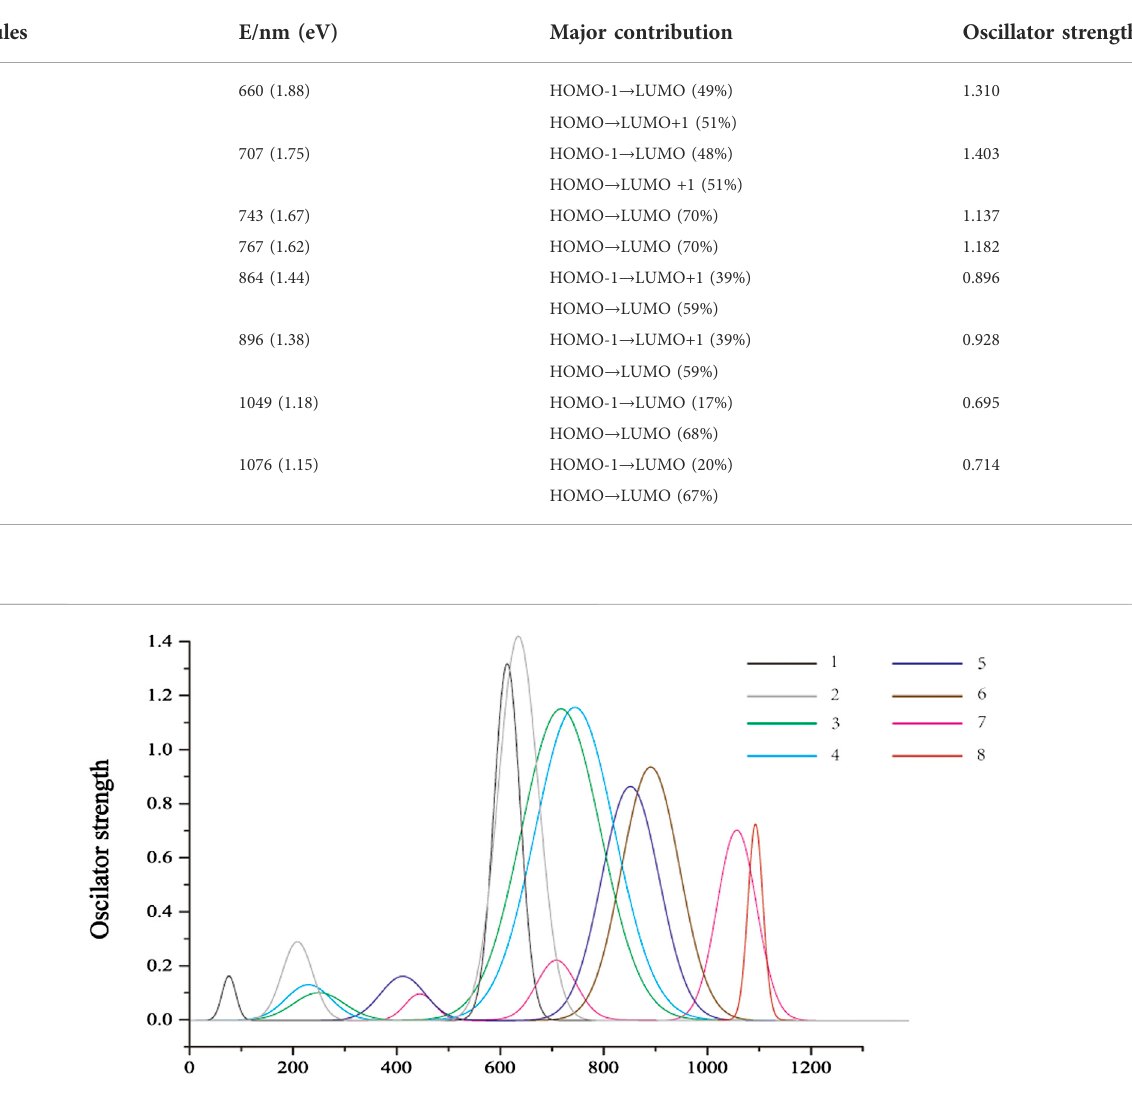
TABLE 4 Calculated absorption features of 1 – 8.